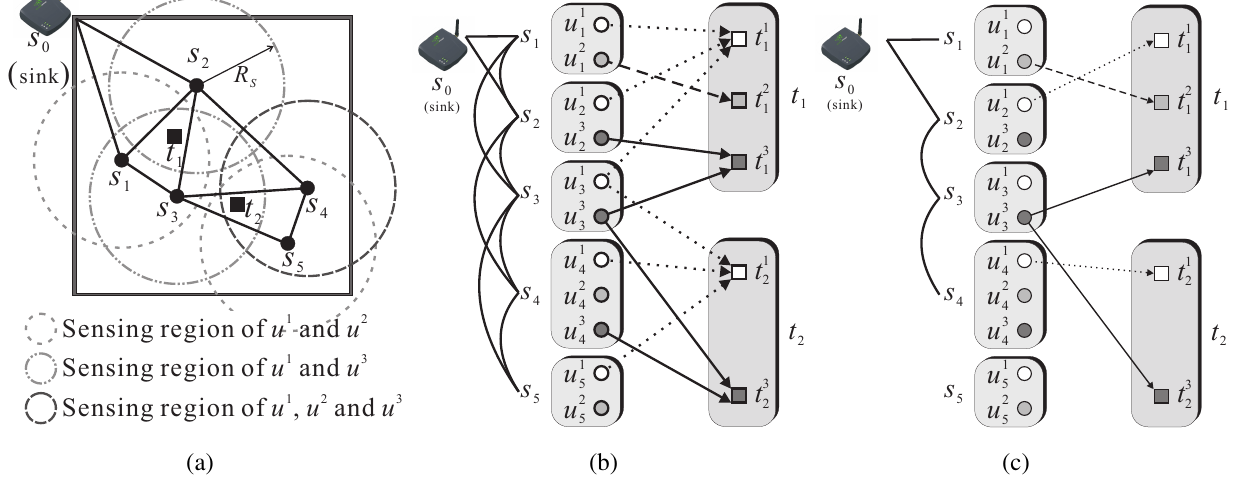
Figure 1. An illustrated example, where five sensors are scheduled to cover two targets. (a) The topology. (b) The coverage and connectivity relationships. (c) An illustration of a connected set